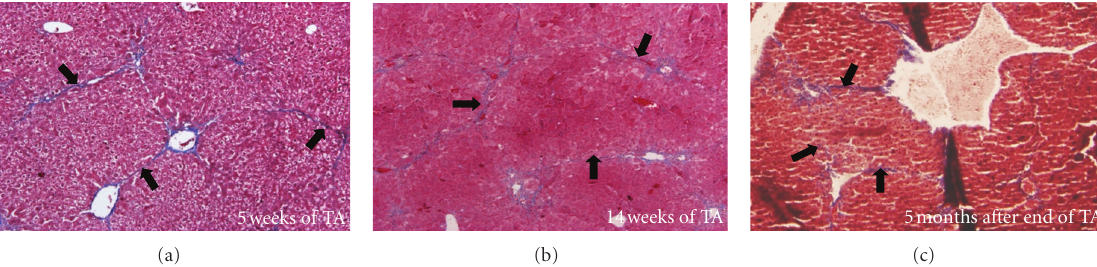
Figure 2: Liver histology after trichrome staining of Nude mice 5 weeks (a) and 14 weeks after the beginning of the thioacetamide cirrhogenic treatment and 5 months after the end of the 14-week-long treatment (c). Black arrows indicate fibrous extension. Photomicrographs were taken using Olympus DP70 microscope with an original magnification of